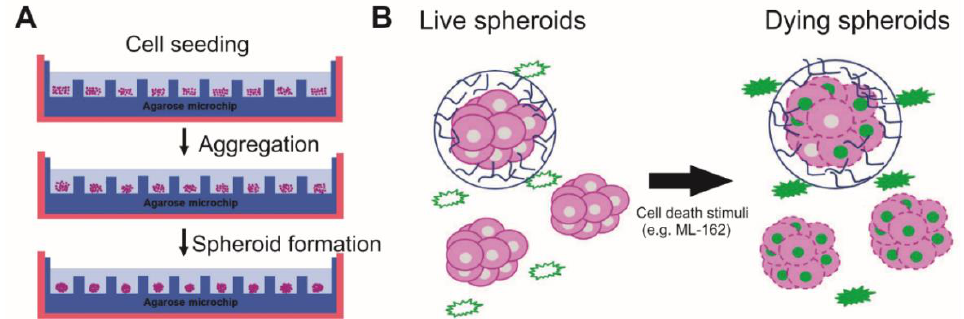
Figure 1. Principles of three-dimensional cell death assay (3DELTA). ( A ) Spheroids are formed by seeding cells on top of an agarose microwell chip. This chip is made by pouring liquid agarose on top of a polydimethylsiloxane (PDMS) mould. Cells will form clusters, leading to the formation of spheroids. ( B ) Sytox Green is nonfluorescent outside of viable cells. When cells are permeabilized at the end of the cell death process and the plasma membrane ruptures, Sytox Green will bind to the DNA and emit green fluorescence, which can then be measured.